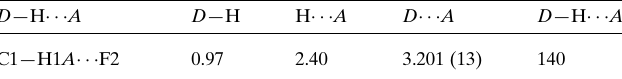
Figure 1 Schematic representation of the formation of the title Table 1 Hydrogen-bond geometry (A˚ , (cid:3) ).